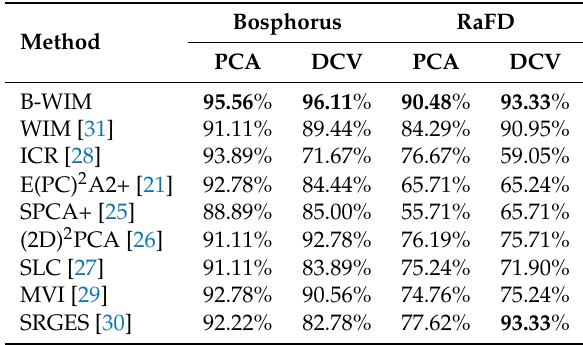
Table 2. Face recognition results in Closed Set protocol.